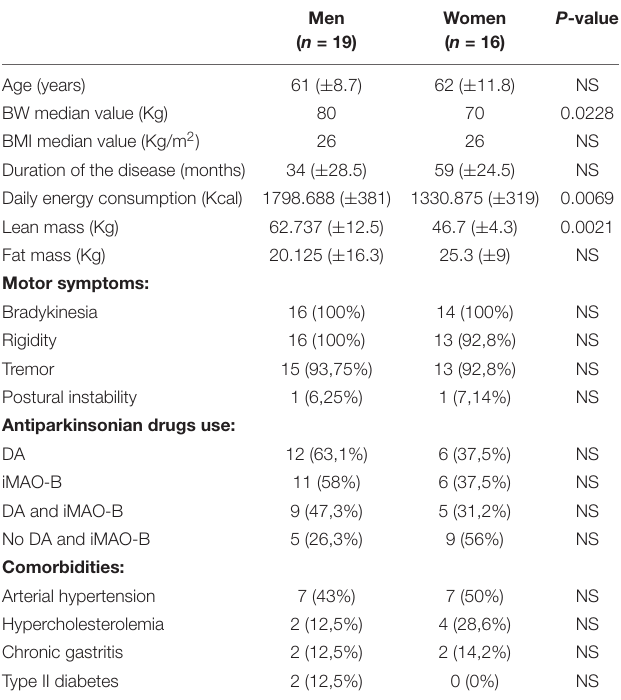
TABLE 1 | Clinical characteristics of the study